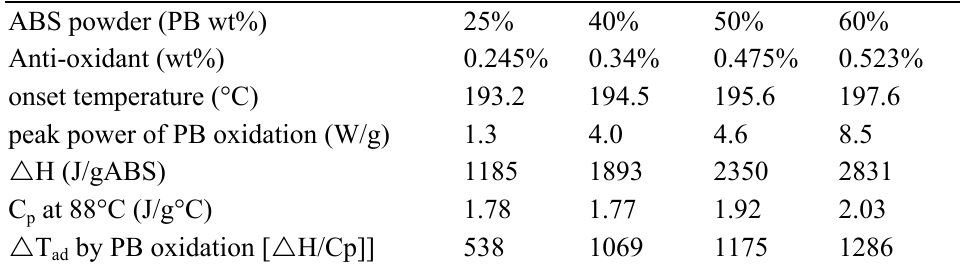
Table 1. Thermal analysis data of ABS powders.